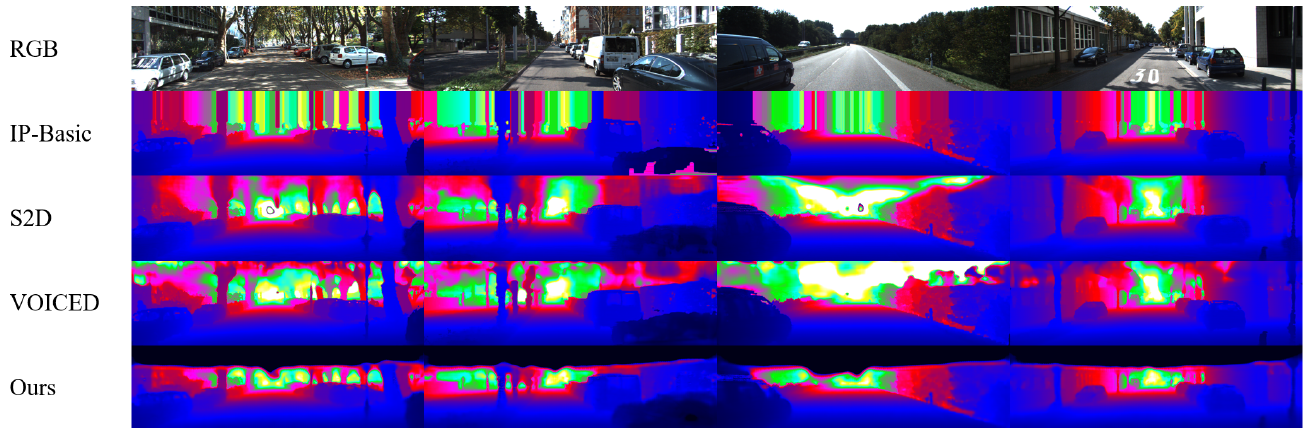
Figure 7. The results of our self-supervised depth completion compared with